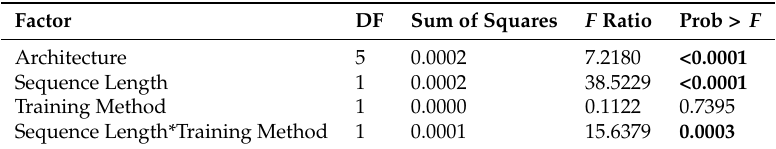
Table 7. Results of the 3-factor ANOVA evaluating the main effects of architecture, sequence length, and two training methods (cross-validated group method and 7-classifier ensemble method), including the interaction effect of training method and sequence length, on cross-participant variance of classification accuracy. Significant results are displayed in bold